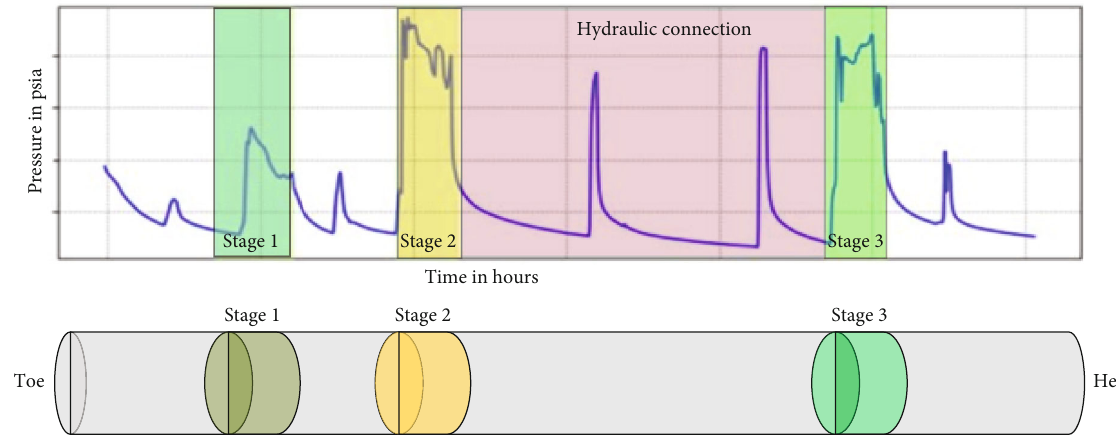
Figure 4: Gauge pressure recordings showing the hydraulic connection between stages modi fi ed after